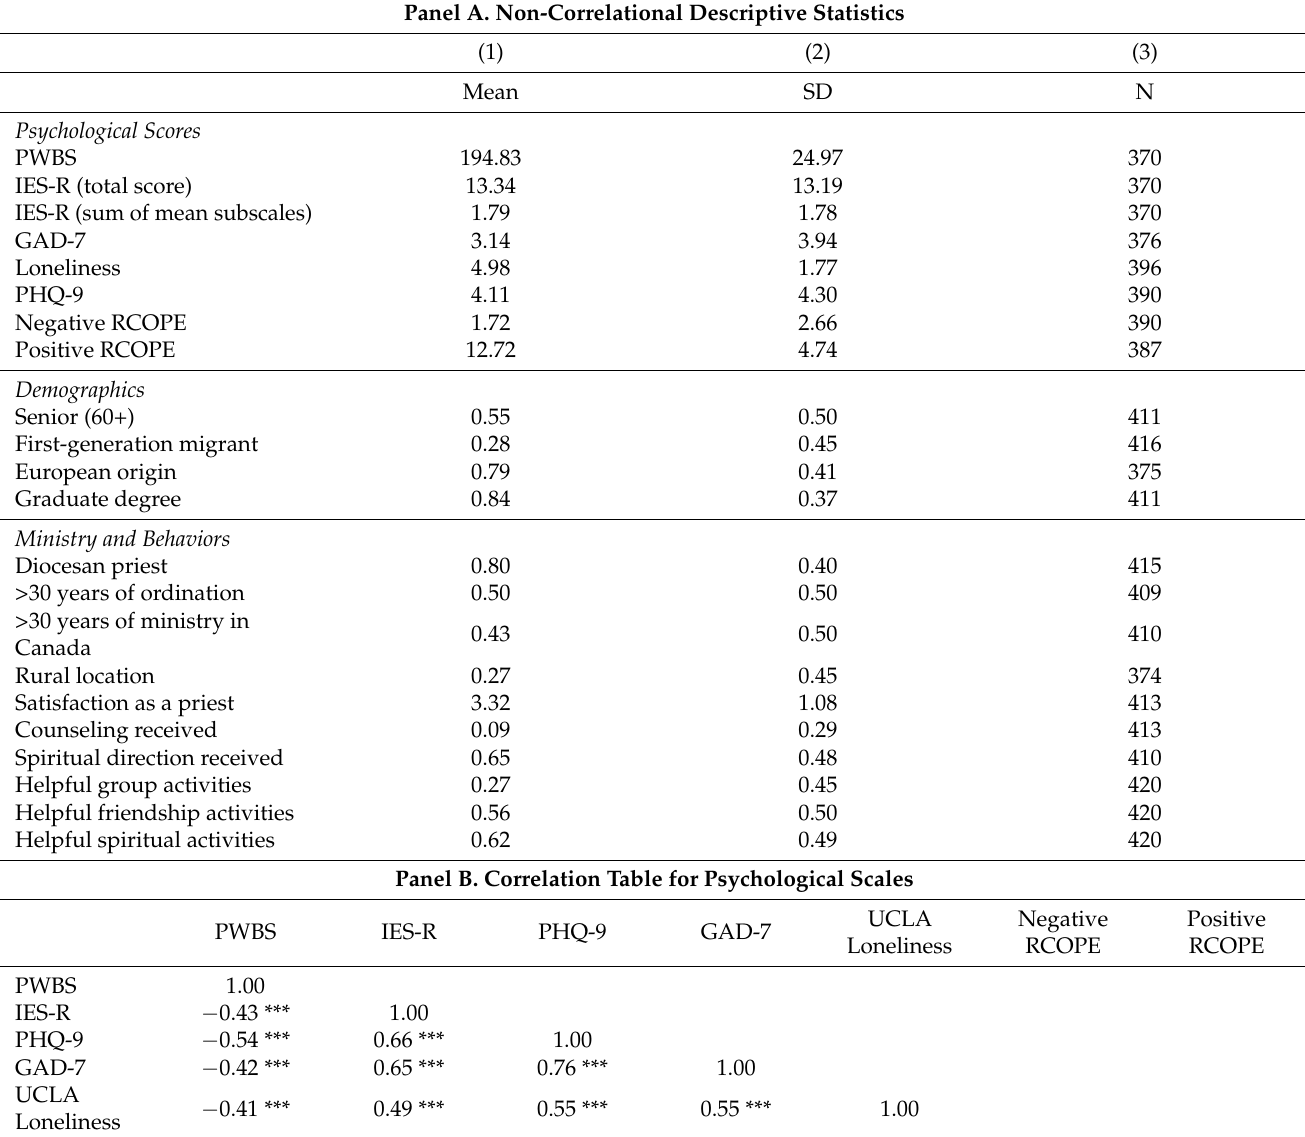
Table 1. Descriptive statistics. Panel A. Non-Correlational Descriptive Statistics